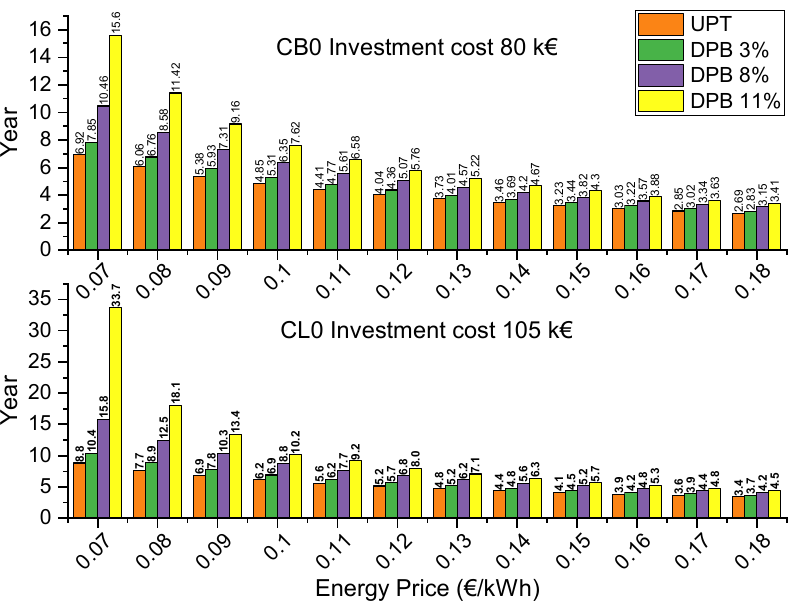
Figure 24. UPT and DPB with D% (3%, 8%, and 11%) for CB0 and CL0.